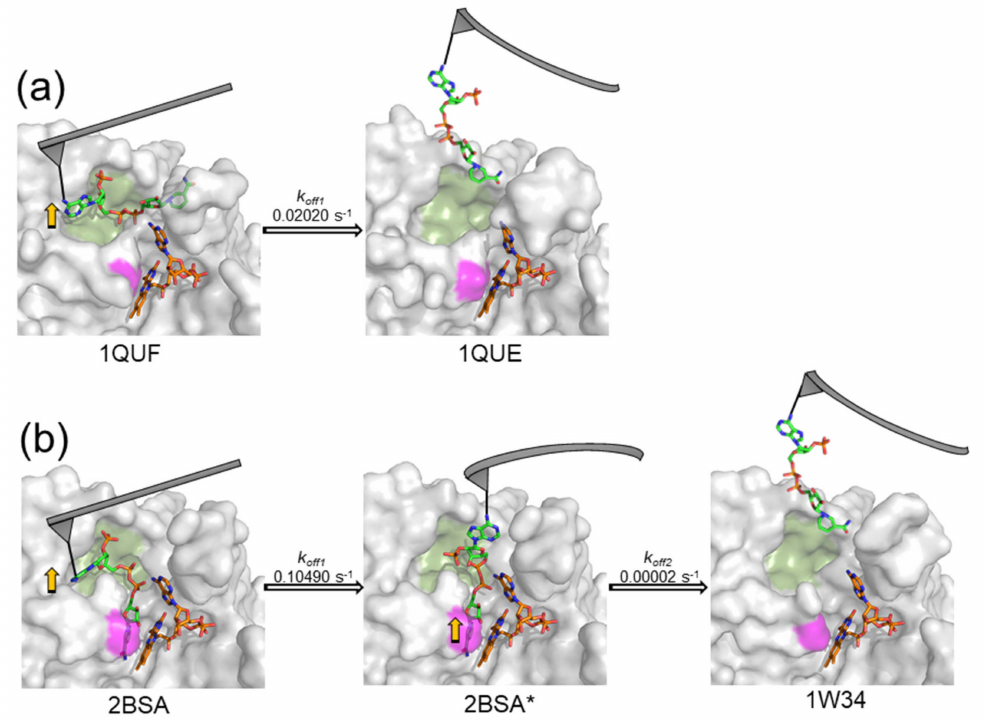
Figure 12. Scheme of force dissociation kinetics steps for ( a ) WT AnFNR ox :NADP + and ( b ) S303 AnFNR ox :NADP + . NADP + is covalently bound to the AFM tip (grey color) through the primary amine of its adenine; therefore, the flexible AFM cantilever pulls from the adenine to dissociate the coenzyme from the enzyme. The FNR enzyme bipartite binding sites for NADP + are coloured in green (2 (cid:48) P-AMP site (1)) and in pink (nicotinamide site (2)). The k off values related to each dissociation step are depicted above the arrows. Yellow arrows indicate where pulling forces are proposed to cause dissociation at each step. Protein structures are based on crystallographic structures with the corresponding PDB codes underneath, except 2BSA* where the intermediate state with NADP + dissociated only from the 2 (cid:48) P-AMP site has been